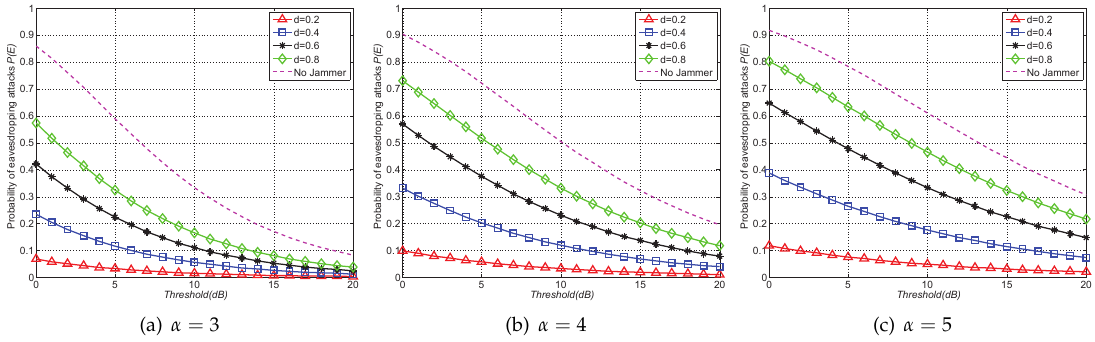
Figure 4. Probability of eavesdropping attacks P ( E ) with FJ-Reg scheme (Grid) versus Non-Jam scheme when α = 3,4,5 with SINR threshold T ranging from 0 dB to 20 dB.